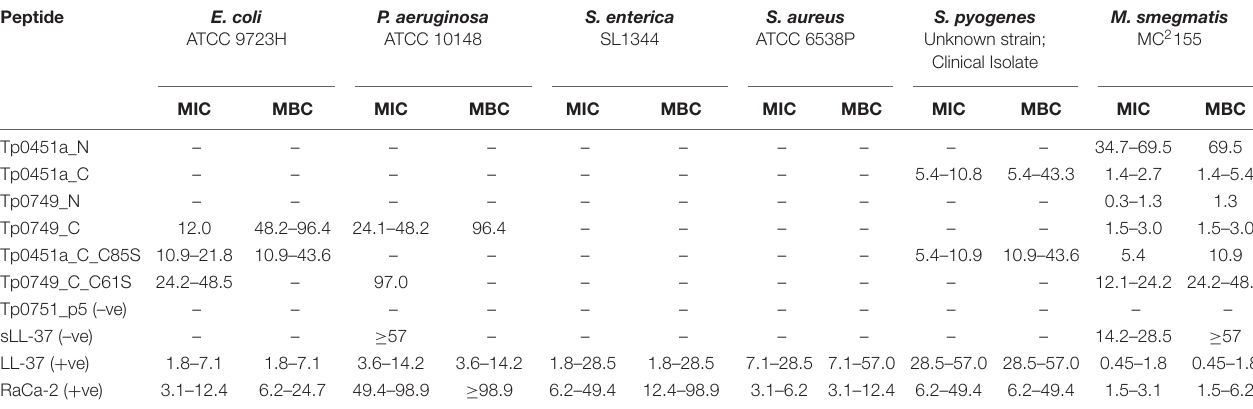
TABLE 4 | Antimicrobial susceptibility testing of T. pallidum candidate AMPCCRs using broth microdilution.